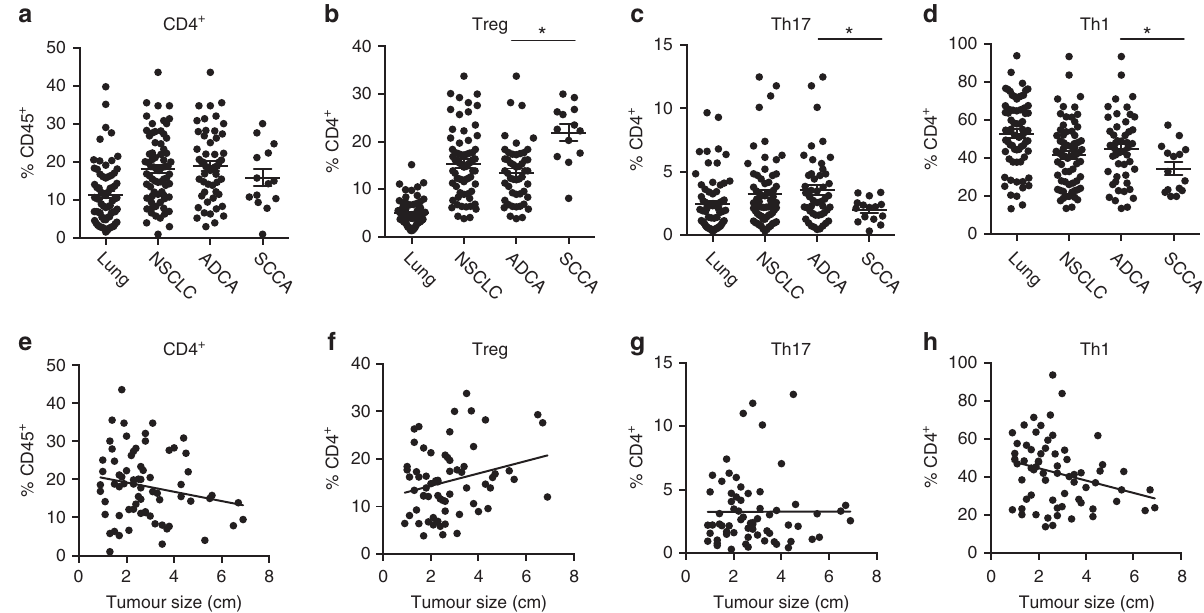
Figure 3 | Differential CD4 þ subset composition for L-ADCA versus L-SCCA. ( a ) CD4 þ cells displayed as % CD45 þ cells, ( b ) Treg (L-ADCA versus L-SCCA, * P o 0.0001, N ¼ 63), ( c ) Th17 (L-ADCA versus L-SCCA, * P ¼ 0.0353, N ¼ 63), and ( d ) Th1 cells (L-ADCA versus L-SCCA, * P ¼ 0.0471, N ¼ 63) shown as per cent of CD4 þ cells. Linear correlations of tumour size (cm) and ( e ) CD4 þ cells ( P ¼ 0.1113, R 2 ¼ 0.0369, N ¼ 53), ( f ) Treg (* P ¼ 0.0402, R 2 ¼ 0.0642, N ¼ 50), ( g ) Th17 ( P ¼ 0.9848, R 2 ¼ 0.0000, N ¼ 48) and ( h ) Th1 cells (* P ¼ 0.0286, R 2 ¼ 0.0727, N ¼ 48) in L-ADCA specimen. Student’s tests were performed to compare two groups ( a – d ) and Pearson correlation calculations were performed for linear correlations ( e – h ). Each dot represents an independent data point as determined by flow cytometry. Data are presented as mean ± s.e.m., * P o